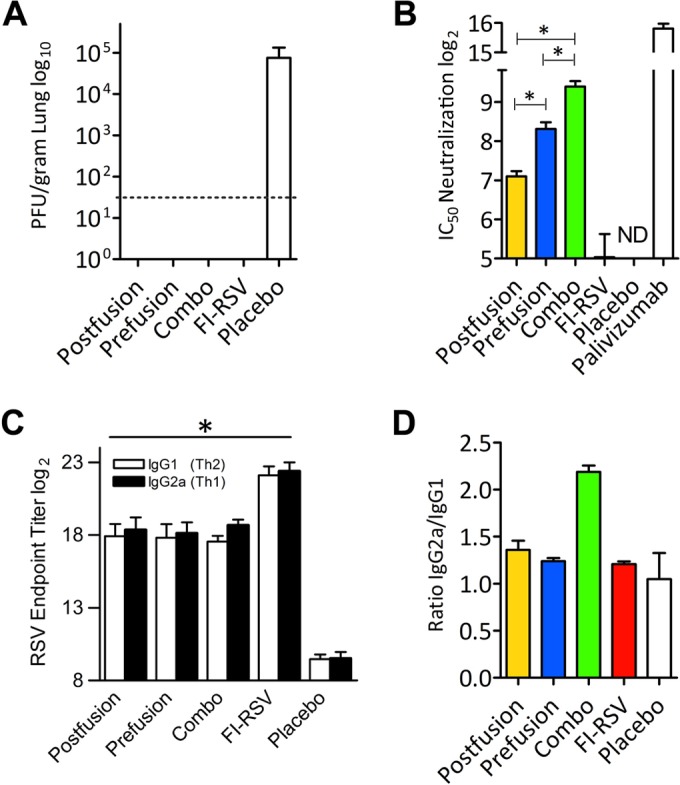
VLP vaccine protects against RSV infection. (A) Plaque assay analysis of viral titers in mouse lungs 4 days postchallenge shows undetectable viral replication in VLP-vaccinated mice, whereas the placebo control group demonstrates a very productive infection. The dotted line indicates the lower detection limit. (B) The viral microneutralization assay shows the levels of serum-neutralizing antibodies after vaccination. The combo VLP vaccination resulted in a statistically significant enhancement of neutralizing antibodies with respect to VLP postfusion and prefusion vaccination (*, P < 0.05). ND, not detectable. (C) Measurement of RSV-specific IgG1 and IgG2a serum antibody titers. Serum samples collected on day 28 postimmunization (n = 4 per group) were assayed for RSV-specific IgG isotypes by ELISA. The results are presented as the reciprocal of the log2 serum endpoint dilution. The antibody titers in the vaccinated mice are statistically significant with respect to the placebo control (*, P < 0.05). (D) Analysis of the ratio of IgG2a to IgG1 demonstrates that the combo VLP vaccine induces a superior Th1-mediated response. The results were generated using 4 mice for each condition.